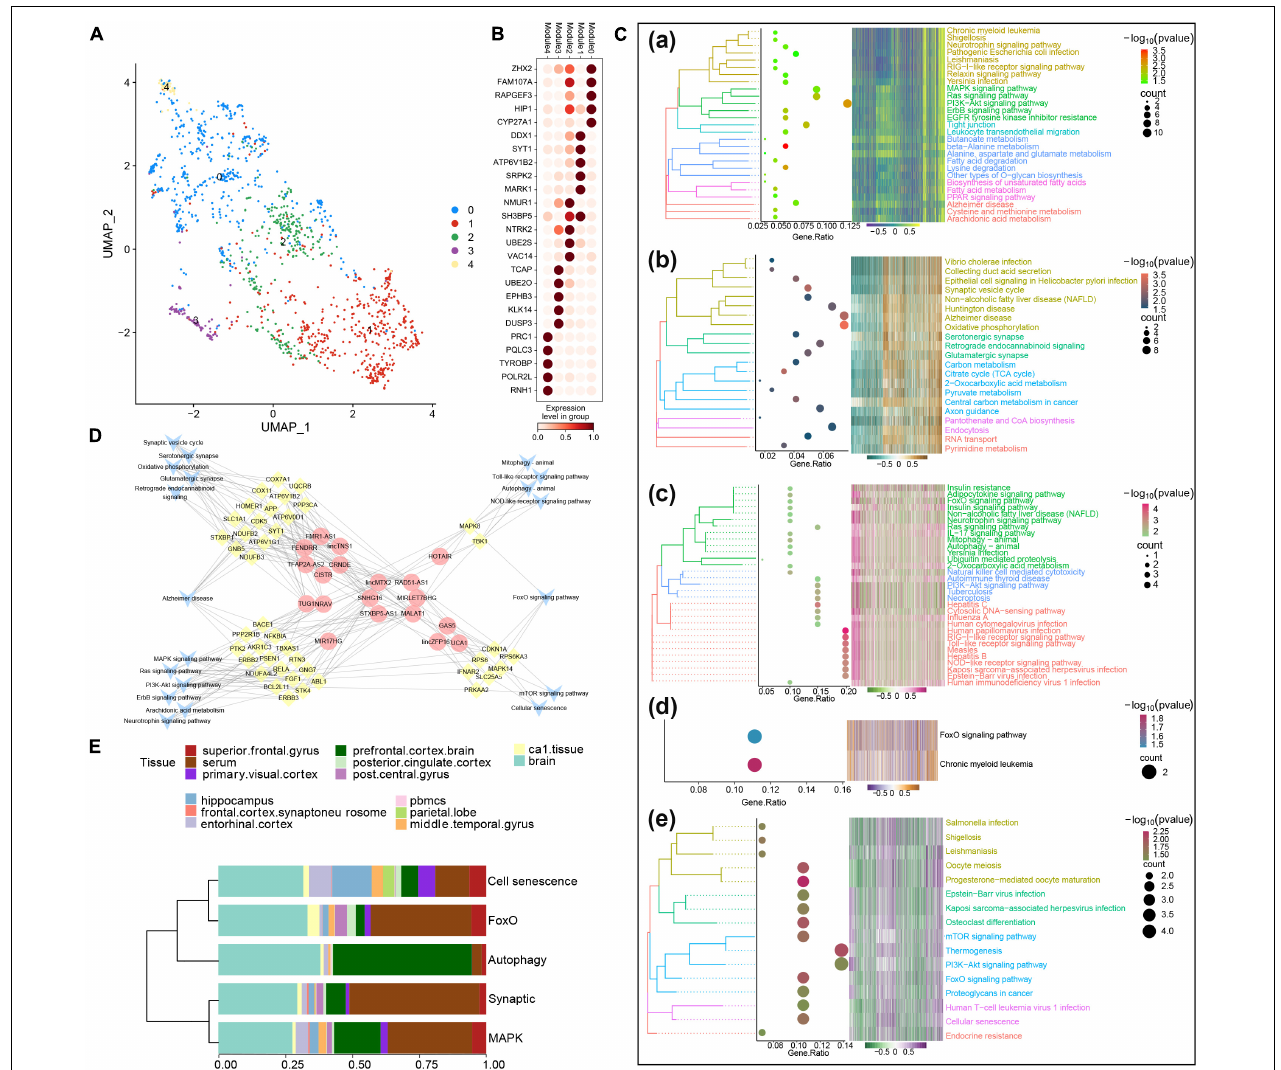
FIGURE 2 | Identification of potential molecular subtypes of Alzheimer’s disease (AD). (A) Clinical cohort AD map. Modules 0–4 contain 495, 475, 246, 90, and 47 AD samples, respectively. (B) Heat map of marker gene expression in each AD sample module. (C) Pathways involving marker genes of different AD sample modules. (D) Comprehensive network of long non-coding RNAs (lncRNAs) regulating different AD sample modules, prepared based on a hypergeometric test. (E) Diagram of components of each AD clinical sample